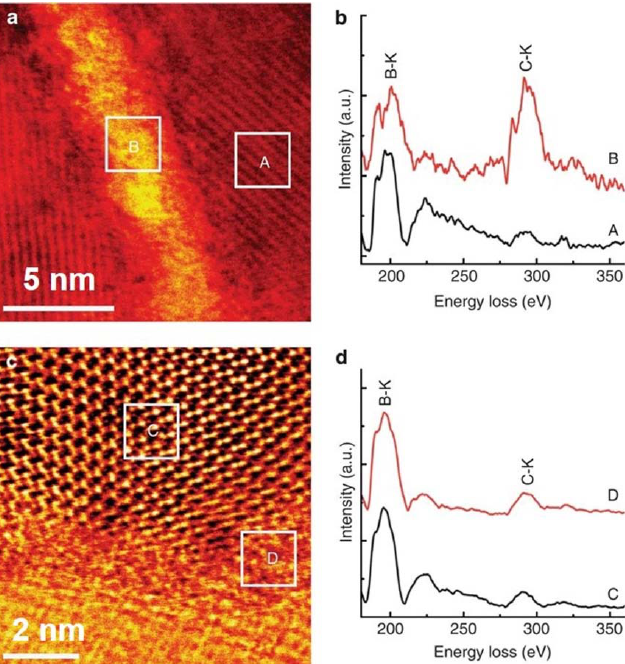
Figure 9. ( a ) BF ‐ STEM image showing broad GB between two grains. ( b ) EELS spectrums corresponding to boxes in Figure 9a. ( c ) BF ‐ STEM image showing narrow GB between two grains. ( d ) EELS spectrums corresponding to boxes in Figure 9c. Reproduced with permission from [58]. Copyright 2022 Nature Communications.